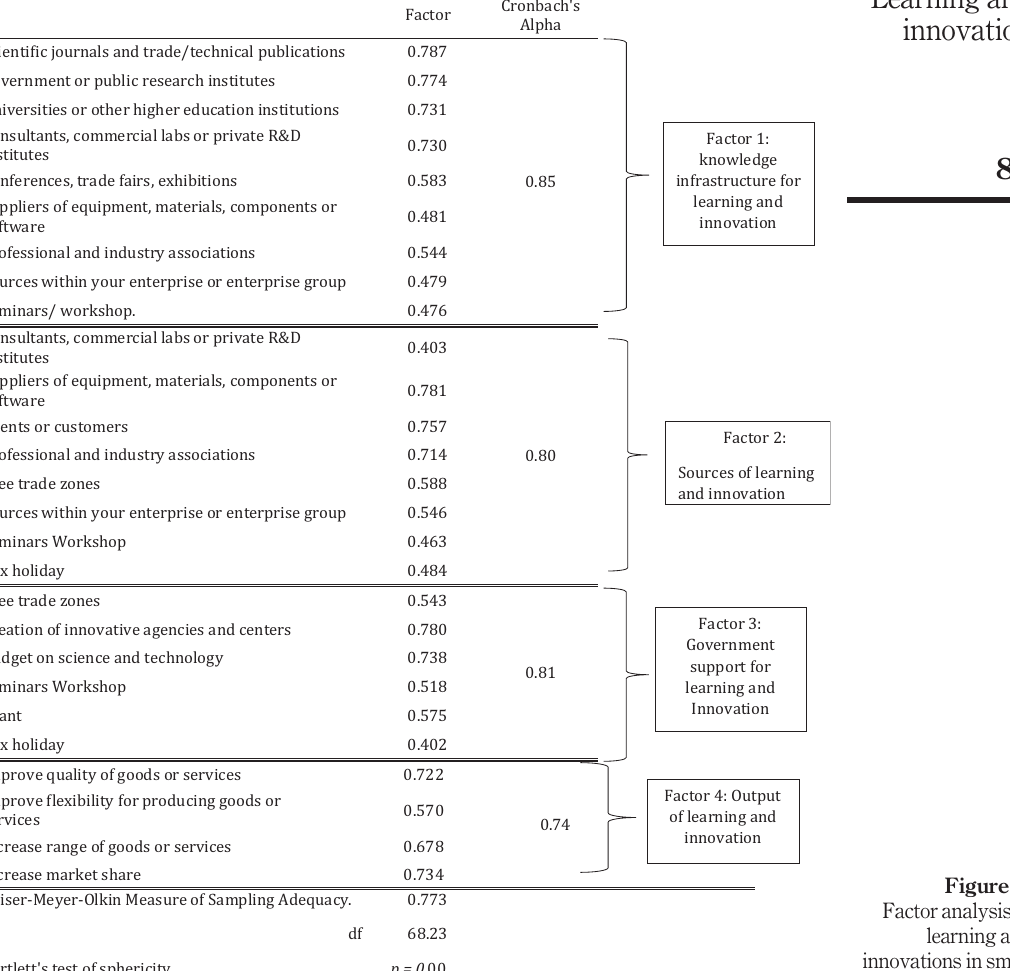
Figure 5. Factor analysis